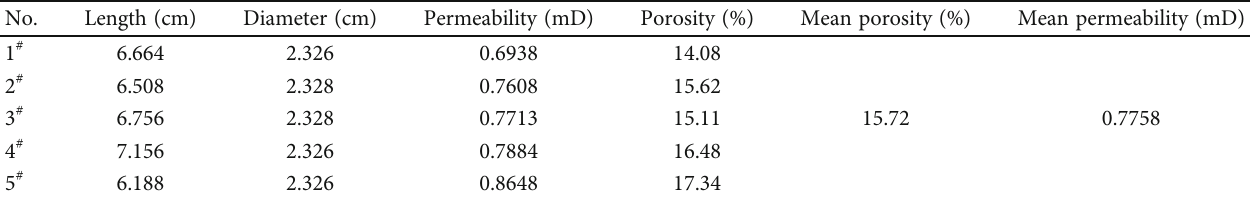
Table 1: Natural short core-related physical